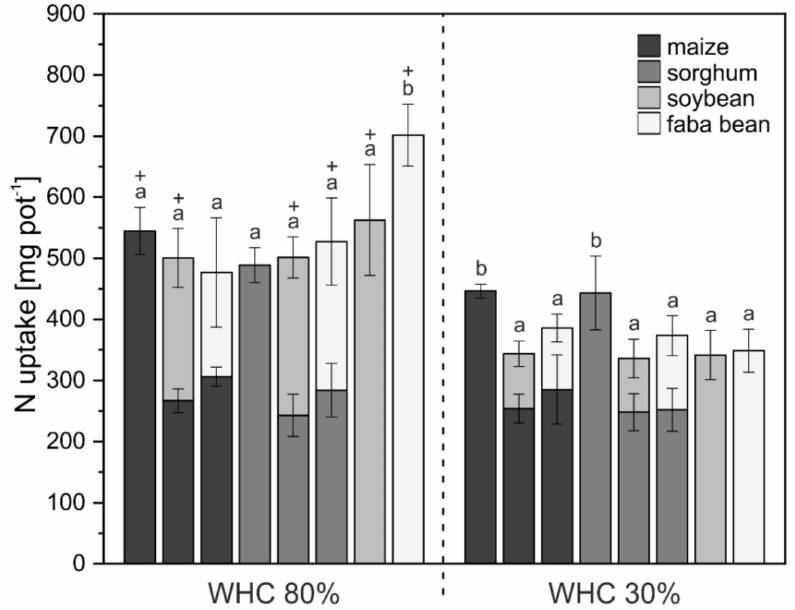
Figure 5. E ff ect of water supply on nitrogen uptake of the crops and mixtures in the Water-Trial (mean ± SD). Di ff erent letters indicate significant di ff erences between the crop variants at each water level, + indicates di ff erences between the water levels (ANOVA and Duncan’s test, p ≤ 0.05). WHC = water holding